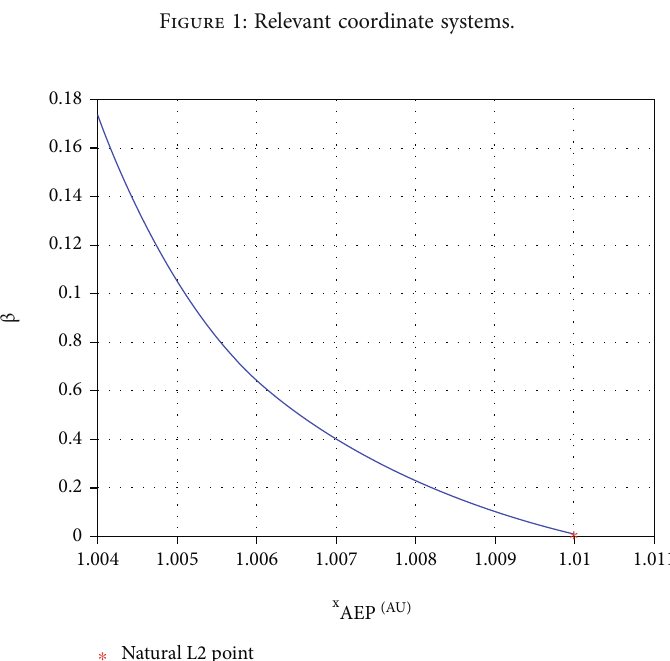
Figure 2: Non-ideal solar sail lightness number β as a function of dimensionless Sun-AEP distance x